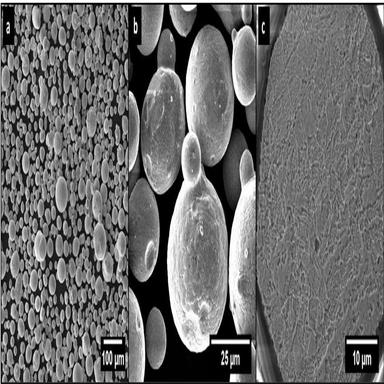
SEM images (secondary electrons mode) of 15-5PH gas atomized stainless steel particles showing a) their spherical morphology, b) the presence of satellite particles and c) the martensitic structure in an atomized particle.